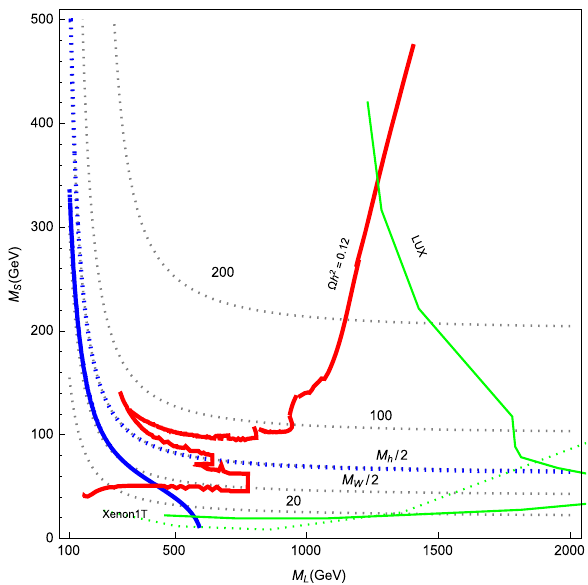
Fig. 3 Constraints on the parameter space of VL dark matter with k = 1 . 2 and tan β = 20. We have shown the relic density of dark matter (red), the latest Xenon1T SI limit [40] (green dotted), LUX SD constraint [41] (green solid), Z invisible decay limit [43] (blue solid), and Higgs invisible decay limit [18] (blue dotted) simultaneously. The contours of VL dark matter masses in unit of GeV are shown in gray dotted curves. Regions on the top of green dotted curve, on the left side of green solid curve, and below the blue curves are